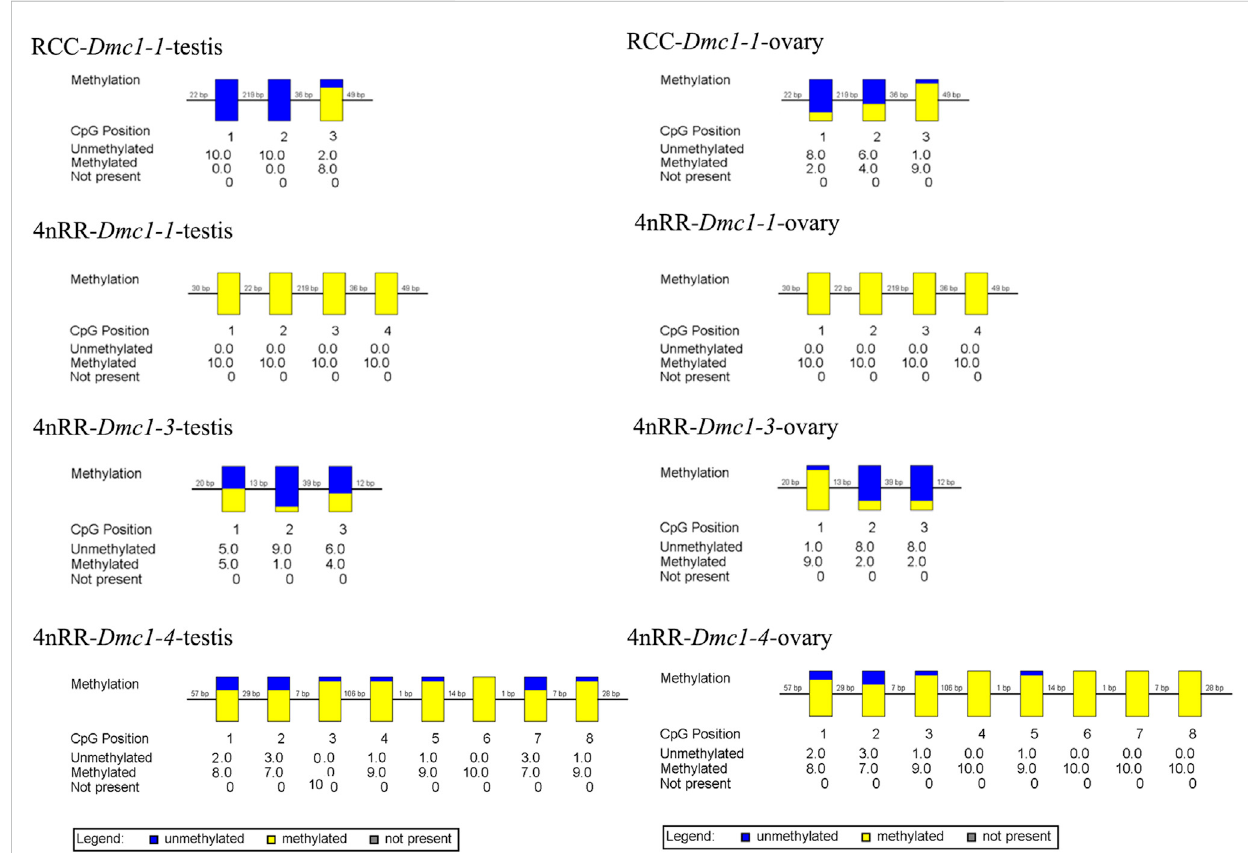
FIGURE 6 The CpG methylation status of different Dmc1 in testes (5-month-old) and ovaries (6-month-old) in RCC and 4nRR; Each box displays one CpG position, where the yellow region represents methylation, and the blue region represents no